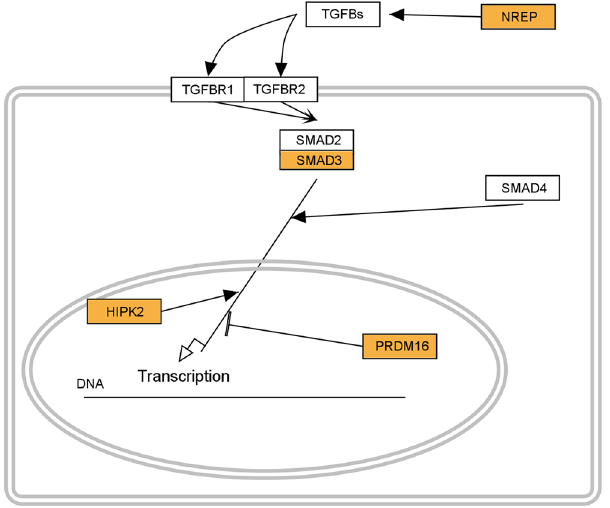
Figure 1. NREP, HIPK2, PRDM16, SMAD3 and their roles in the canonical TGF- β signalling pathway. The region-dependent accumulation of rare variants dataset was significantly enriched in the genes connected to the TGF- β pathway. Highlighted are the four genes contained in the dataset. Interactions were drawn using Pathvisio